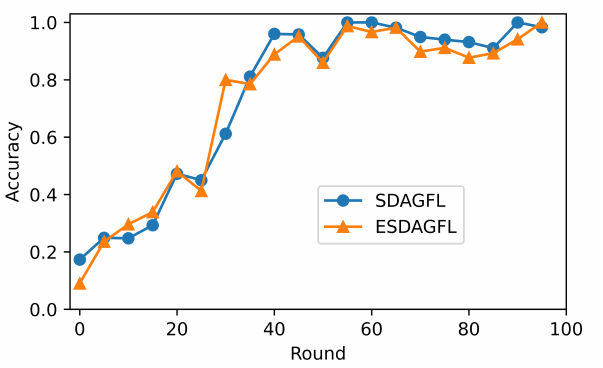
Figure 3. The average training accuracy of ESDAGFL and SDAGFL evaluated on the FMNIST- clustered dataset.